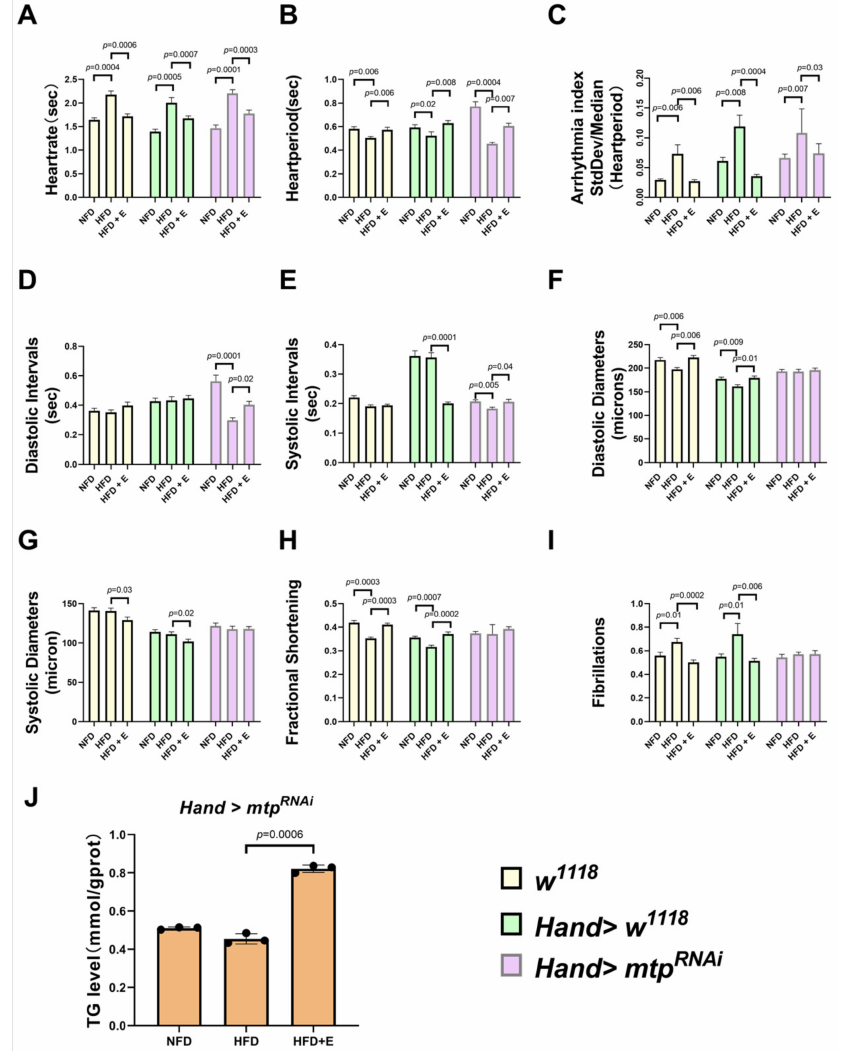
Figure 6. Effect of inhibition of cardiac mtp and exercise training on cardiac function and Hand > mtp RNAi whole-body TG levels in Drosophila . ( A – I ) Under different treatments, cardiac function assays included HR, HP, AI, DI, SI, DD, SD, FS and FL. NFD + w 1118 , HFD + w 1118 , HFD + E+ w 1118 , NFD + Hand > w 1118 , HFD + Hand > w 1118 , HFD + E + Hand > w 1118 , NFD + Hand > mtp RNAi